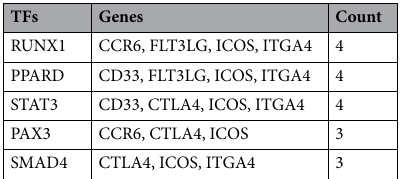
Table 3. The transcription factors of key